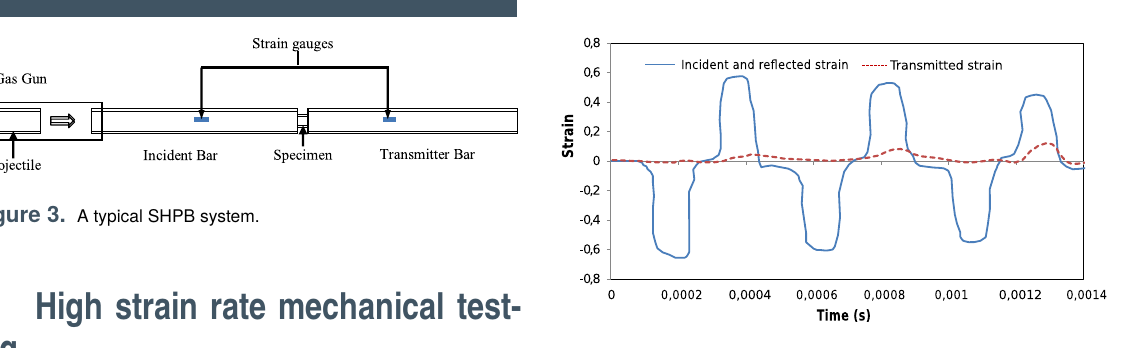
Figure 4. Incident, reflected and transmitted strain pulses for HDPE